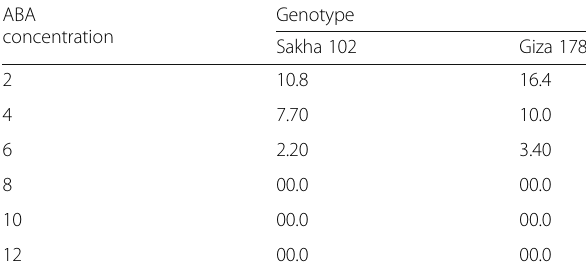
Table 2 Means of shoot formation (%) as influenced by genotype and ABA concentration for stepwise selection ABA concentration